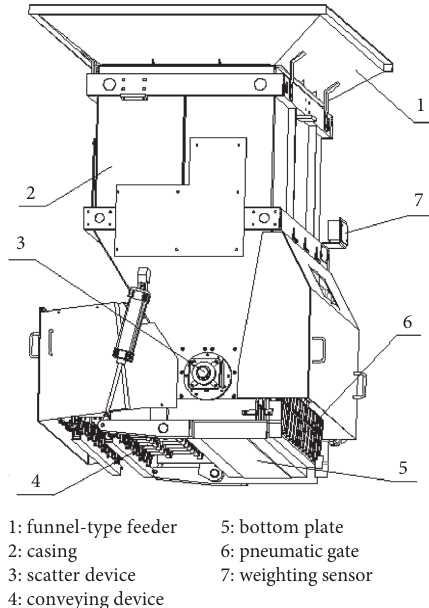
Figure 2: The dispersing